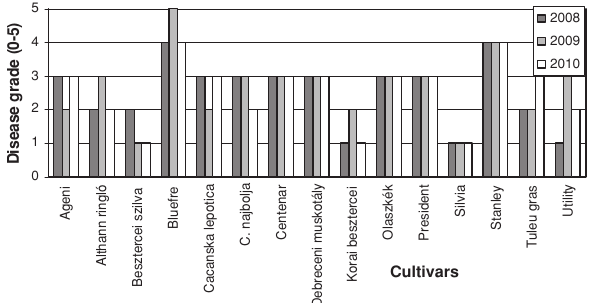
Figure 2: Susceptibility of fruit of plum cultivars to Monilinia spp. (Kecskemét,